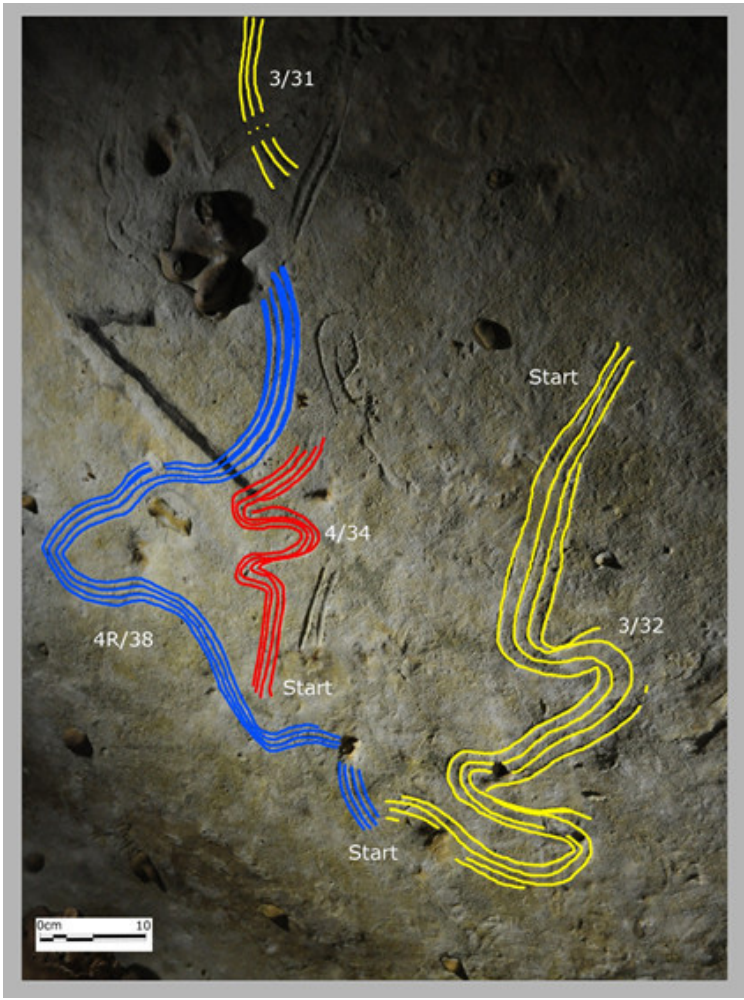
Figure 7. Flutings by three individuals at a terminal end of Rouffignac: the flutings of the smallest child (31mm) are highlighted in yellow, a female child (34mm) in red, and the male adult (38mm) in blue. Multiple individuals fluting in close proximity appears common. The stratigraphy of flutings by at least two individuals each from Rouffignac, Las Chimeneas, and Gargas suggests that the individuals fluted simultaneously. Figure 8 presents evidence indicating that two of the Rouffignac children were likely fluting simultaneously; likewise in Las Chimeneas there is evidence that two children were